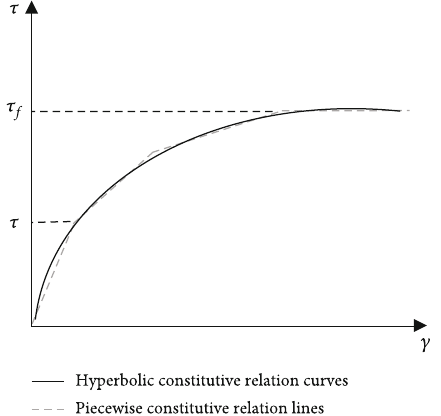
Figure 7: The diagram of the relationship between shear stress and shear strain.